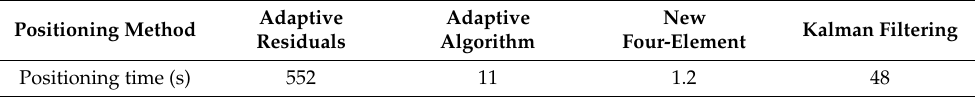
Table 5. The positioning processing time of the three